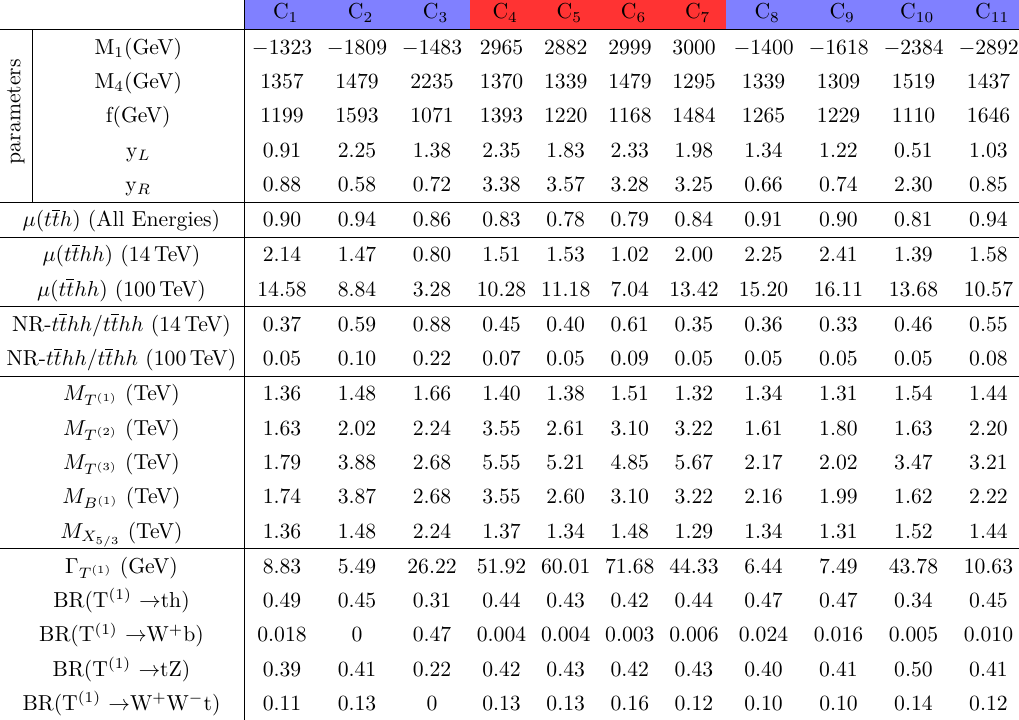
Table 5 . Benchmark points for the MCHM 5 at low scale and their main features. Red and blue column headings indicate points belonging to Region I and II